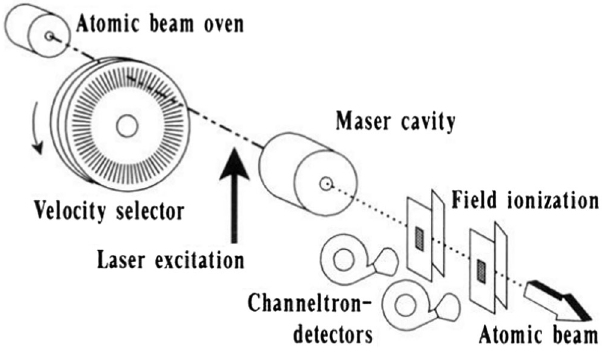
FIG. 6. Sketch of a micromaser setup. The units are produced in an atomic beam oven and are initialized with a velocity selector and laser excitation. They then interact with a microwave ( “ maser ” ) cavity (the system) before they are finally detected and their state is read out. The figure is taken from Ref. [174], reporting on experimental observation of sub-Poissonian photon statistics in a